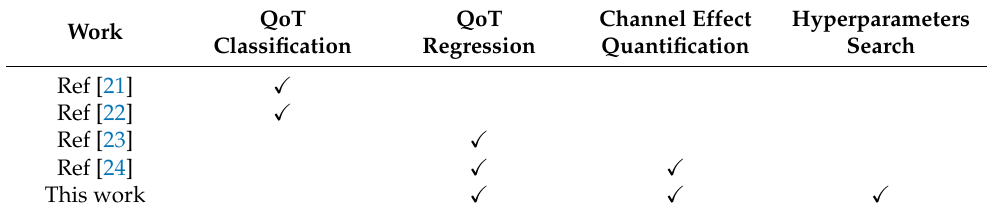
Table 1. Comparison of this work with the previous